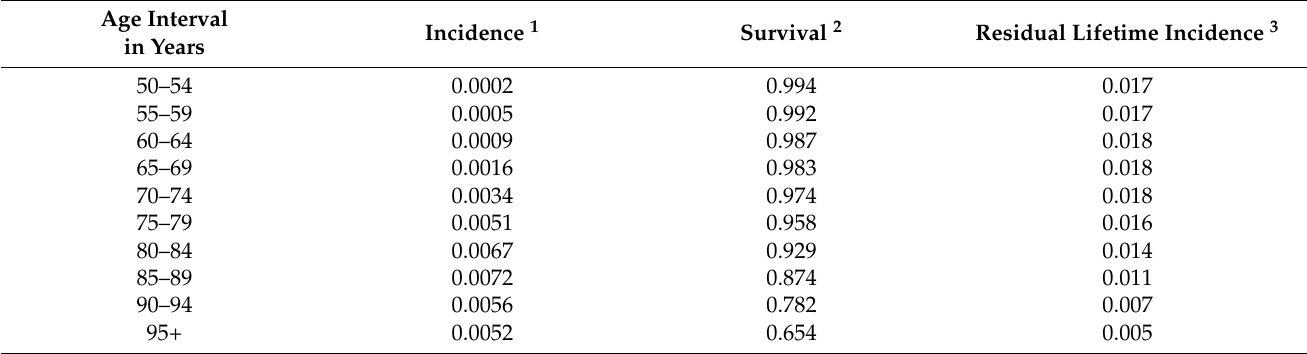
Table A3. Incidence of PD in different age groups.